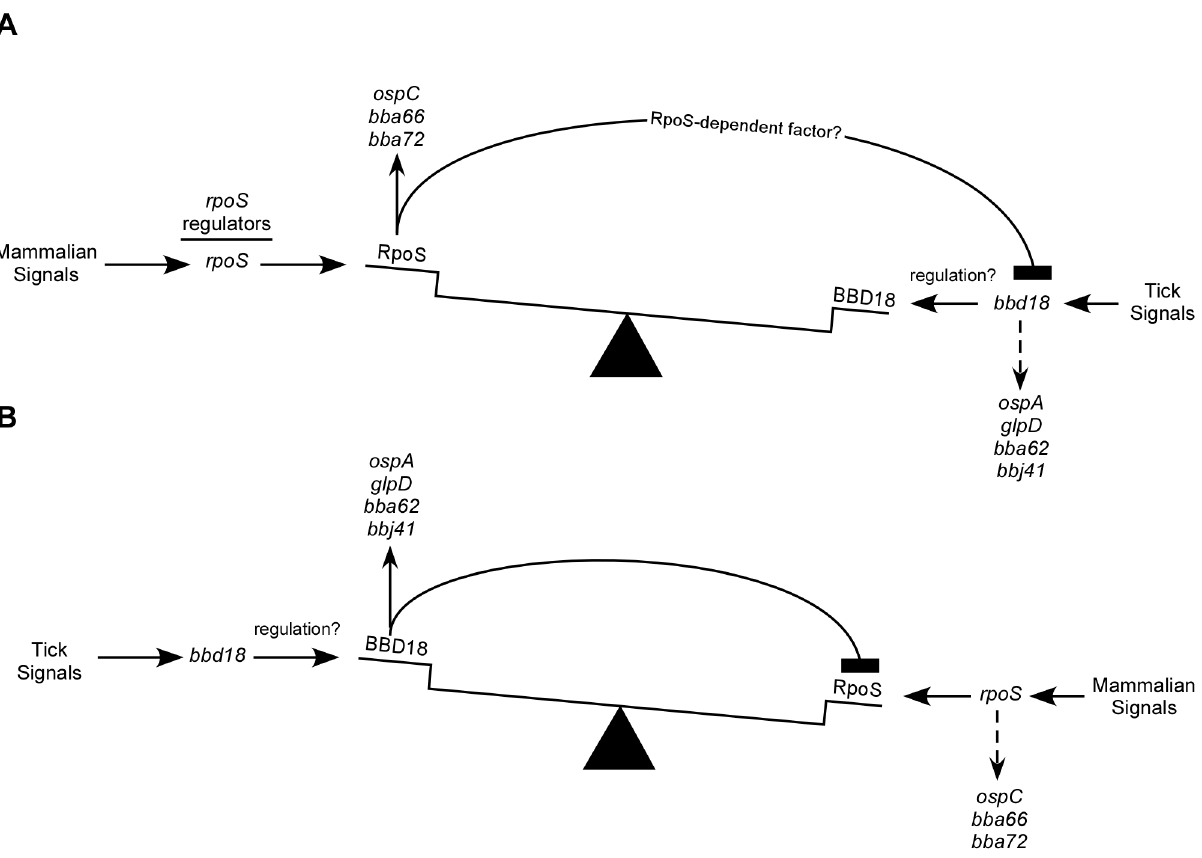
Figure 6. Proposed balance between RpoS and BBD18 in B.burgdorferi . (A) In response to mammalian environmental conditions, expression of rpoS is induced. Several factors, including BosR, CsrA, Hfq, DsrA and BadR, play roles in regulating rpoS . When RpoS protein is available to bind RNAP, it directs the expression of ospC , bba66 , bba72 and other RpoS-dependent genes. RpoS represses transcription of bbd18 , ospA , glpD , bba62 , bbj41 and other arthropod-induced genes, possibly through an RpoS-dependent factor[51]. (B) In response to arthropod environmental conditions, bbd18 is expressed and BBD18 production destabilizes RpoS and represses RpoS-dependent transcription, allowing induction of genes required in the arthropod